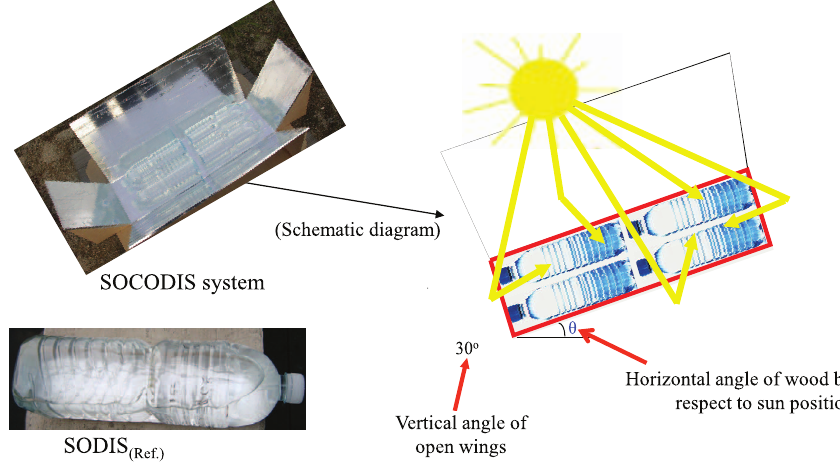
Figure 1. Demonstration of SODIS (Ref.) and SOCODIS systems.